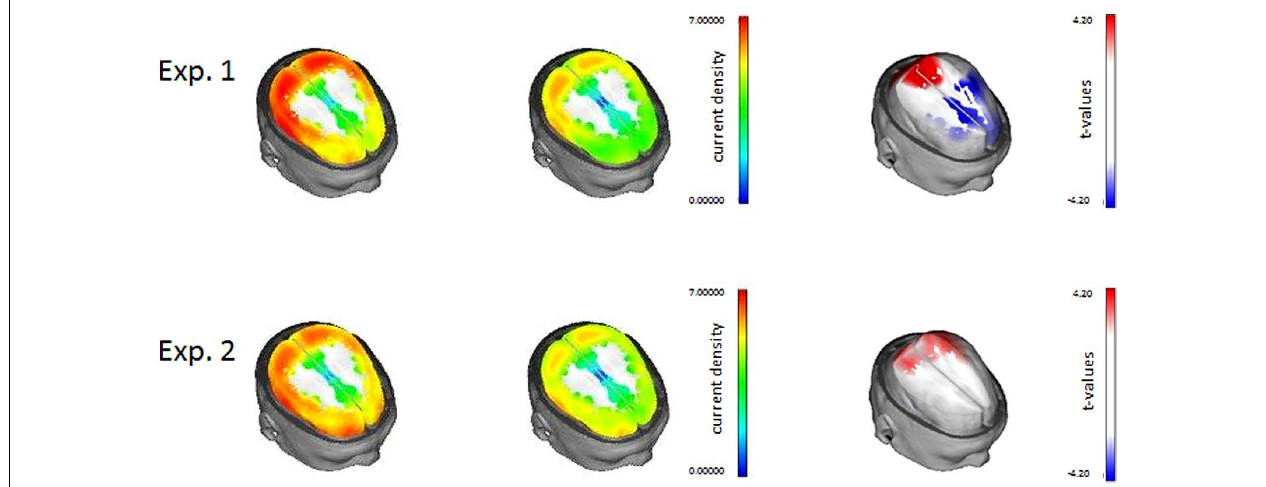
FIGURE 3 | Results from low resolution brain electromagnetic tomography analysis (LORETA) for Experiment 1 (top) and Experiment 2 (bottom). On the left side the 1st and 2nd half data are presented, the colorbar indicates current density. On the right side the transition effect is presented; the colorbar indicates t